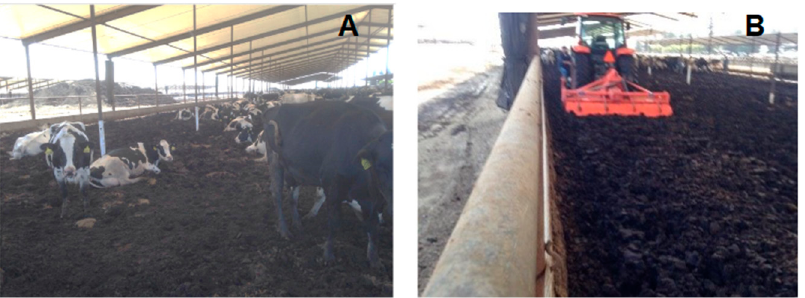
Figure 5. Cows in compost-bedded pack barn ( A ), and rotary tiller agitating bedding materials in a compost-bedded pack barn ( B